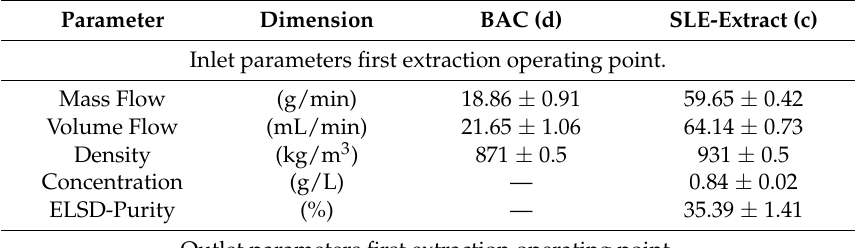
Table 2. Inlet and outlet parameters for the first and second operating point in the extraction column. Concentration and purity of artemisinin are obtained by High performance liquid chromatography (HPLC). BAC (butyl acetate), SLE (solid-liquid extraction), ELSD (evaporative light scattering